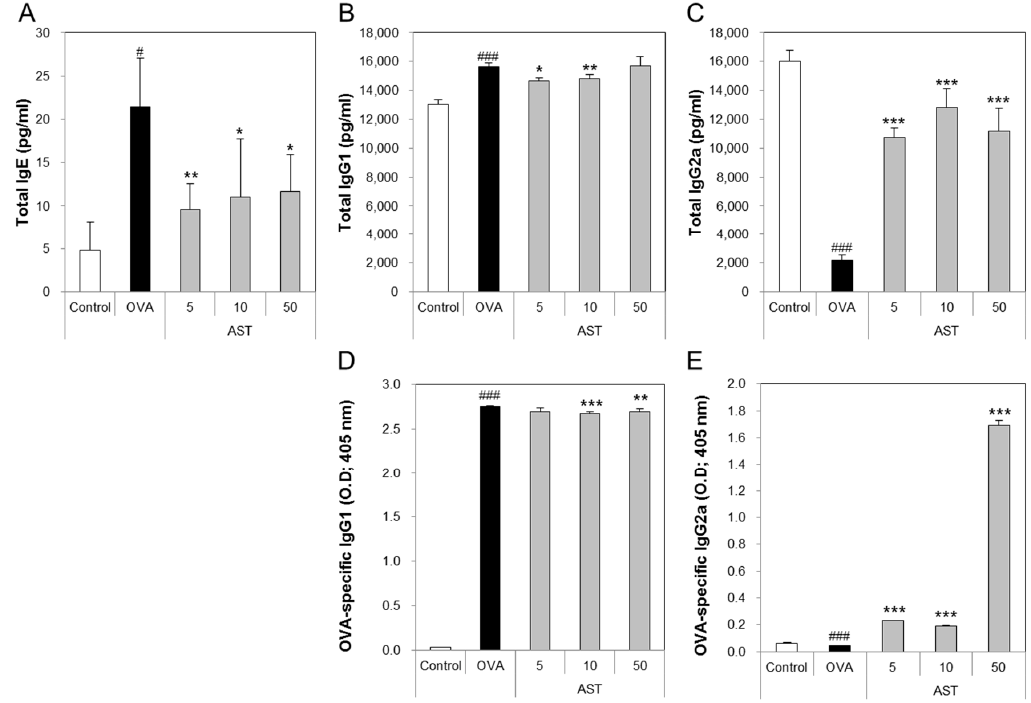
Figure 4. Effects on total cells and Th1 and Th2-mediated immunoglobulins of AST in serum. C57BL/6 mice were sensitized and challenged with OVA and AST. In these mice, serum were collected 24 h after the last challenge. ( A ) The total IgE; ( B ) IgG1; ( C ) IgG2a; ( D ) OVA-specific IgG1; and ( E ) OVA-specific IgG2a were measured by ELISA. The data represent four mice per group. All data were expressed as means ± SD. # p < 0.05 and ### p < 0.001 control vs. OVA. * p < 0.05, ** p < 0.01, and *** p < 0.001 OVA vs. AST.